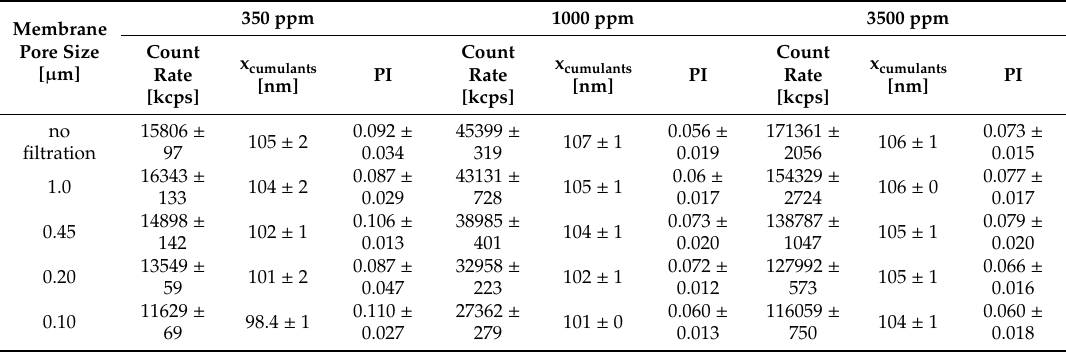
Table 4. DLS results of silica suspensions (Levasil ® ) with di ff erent solid contents filtered with OMNIPORE ® membranes. All measurements were carried out with same laser intensity.